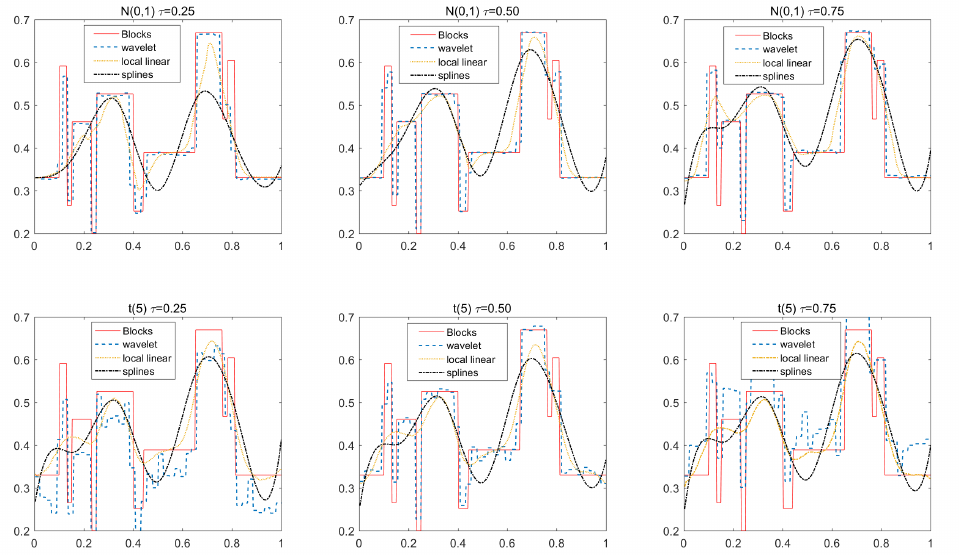
Figure 2. The true time-varying coefficient function Blocks and their QR-wavelet, QR-local-linear and QR-splines estimates when n = 300, and τ = 0.25, 0.50 and 0.75 for the errors N ( 0,1 ) and t ( 5 )